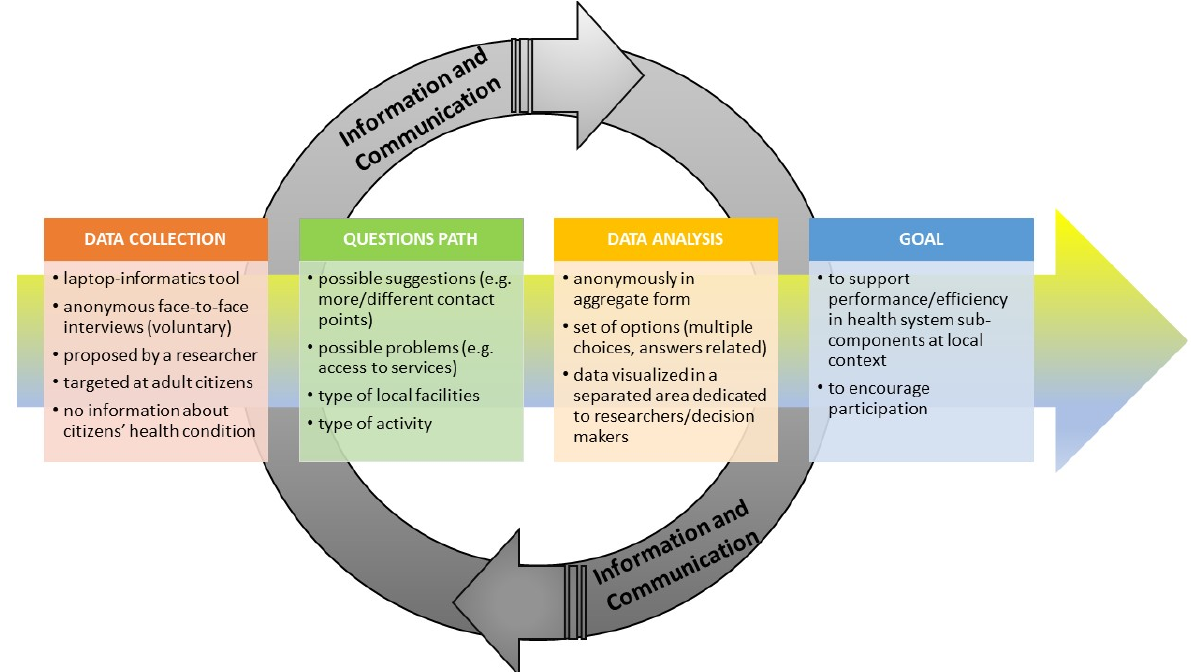
Figure 1. New informatics tool proposed.